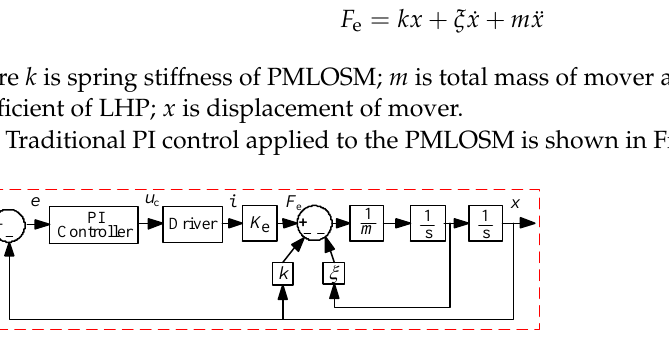
Figure 6. Traditional PI control sketch of